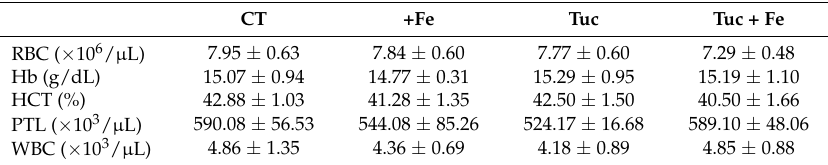
Table 2. Effect of iron and/or tucum-do-cerrado intake in the hematological parameters of adult rats treated for 12